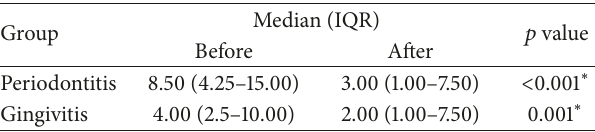
Table 5: Association between intragroups of OHIP-14 item score before and after NSPT ‡